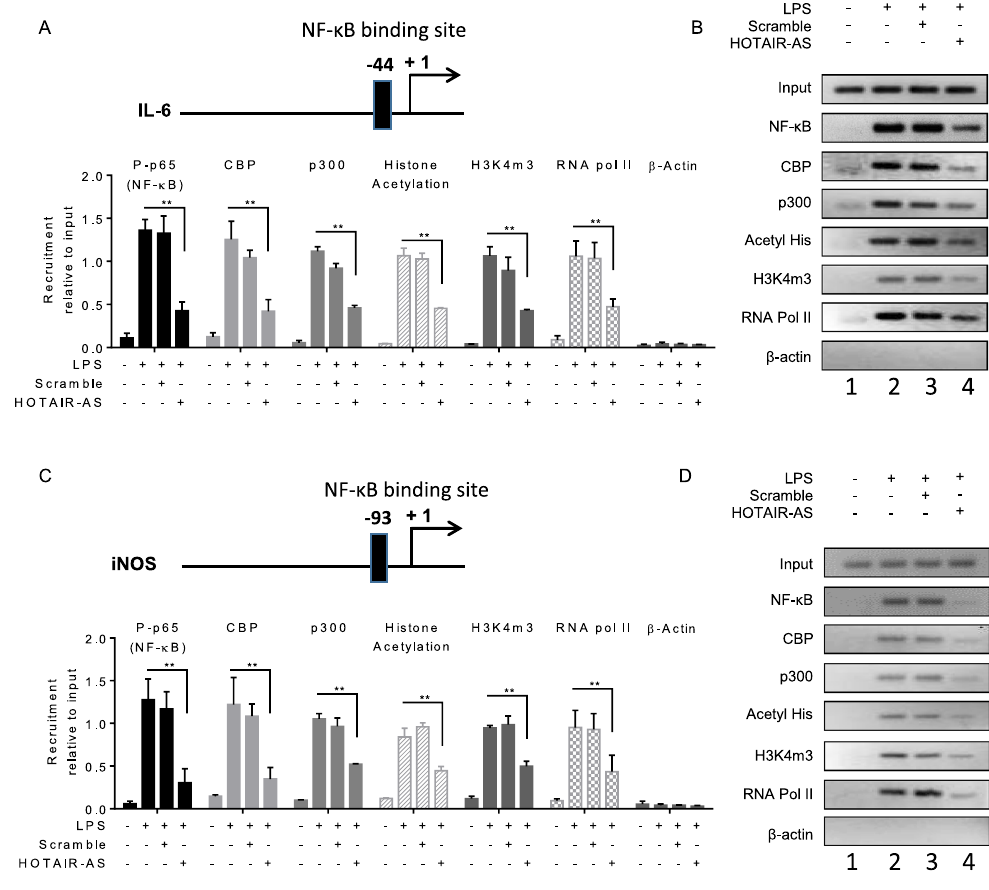
Figure 6. Knockdown of HOTAIR reduces the recruitment of transcription factors and coactivators at NF- κ B binding sites on IL-6 and iNOS promoters. RAW264.7 macrophage cells were transfected with HOTAIR or scramble-antisense, then treated with LPS (1.5 h). Cells were then fixed with formaldehyde and subjected to ChIP assay using antibodies specific to phospho-p65, CBP, p300, histone acetylation, H3K4m3, RNA pol II and β -actin (control). The immunoprecipitated DNA fragments were analyzed by qPCR (panels A shows the ChIP analysis for IL-6, and C for iNOS) and semi-quantative PCR (panels B and D) using primers specific to the NF- κ B binding regions on IL-6 and iNOS promoters. The location of NF- κ B binding sites at the IL-6 and iNOS promoters are shown at the top of panels A and C respectively. Each experiment was repeated at least thrice (n = 3). Data represent mean ± SD; * p < 0.05, ** p <